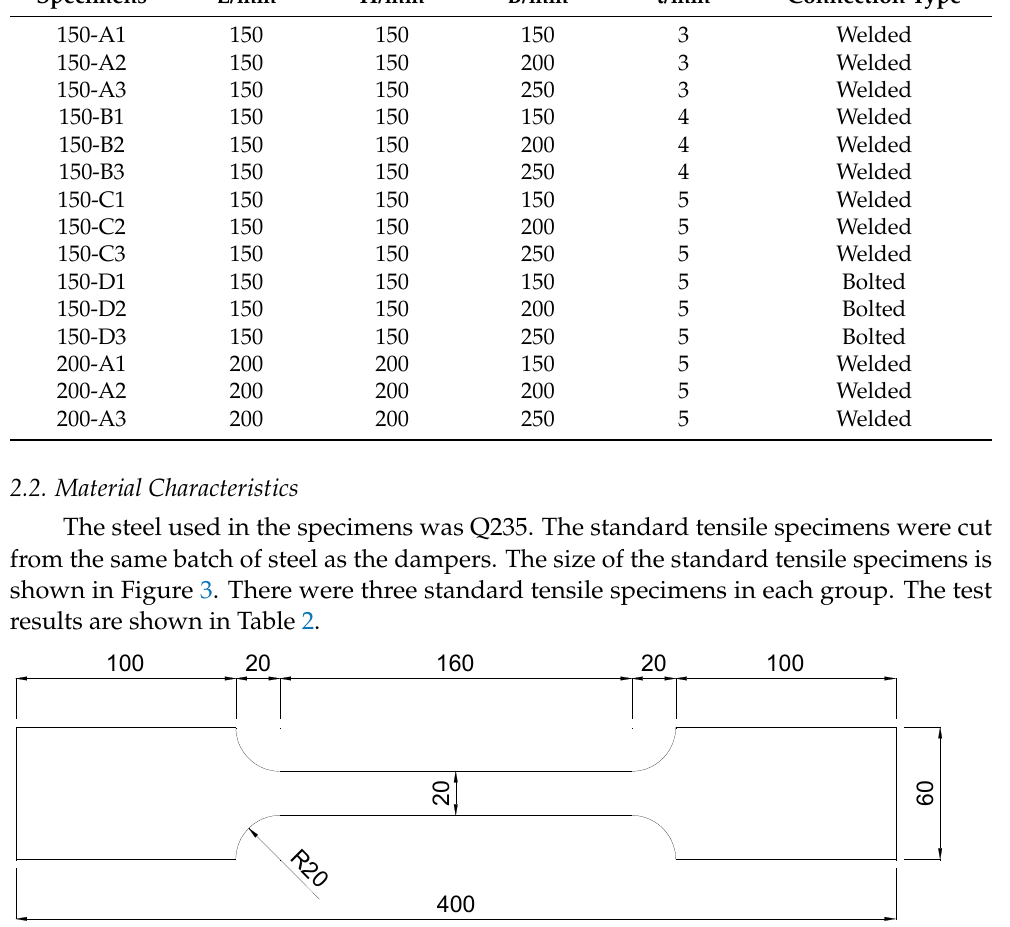
Table 1. Design parameters of the specimens.